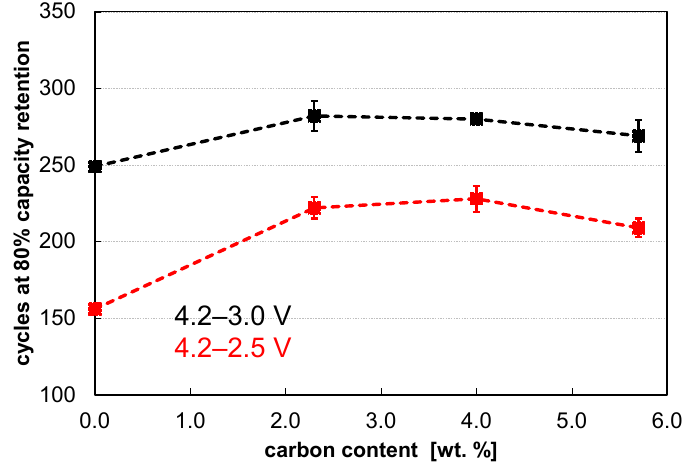
Figure 5. Cycle life (at 80% capacity retention) of full cells with silicon anodes based on carbon coated CLM00001 (standard PSD) as a function of carbon content. Cycle numbers represent mean values in a series of three cells, error bars indicate the standard deviation. The carbon coating improves the cycle life particularly in the 4.2–2.5 V window where the conductivity of the silicon particles is reduced by substantial delithiation at lower voltages.